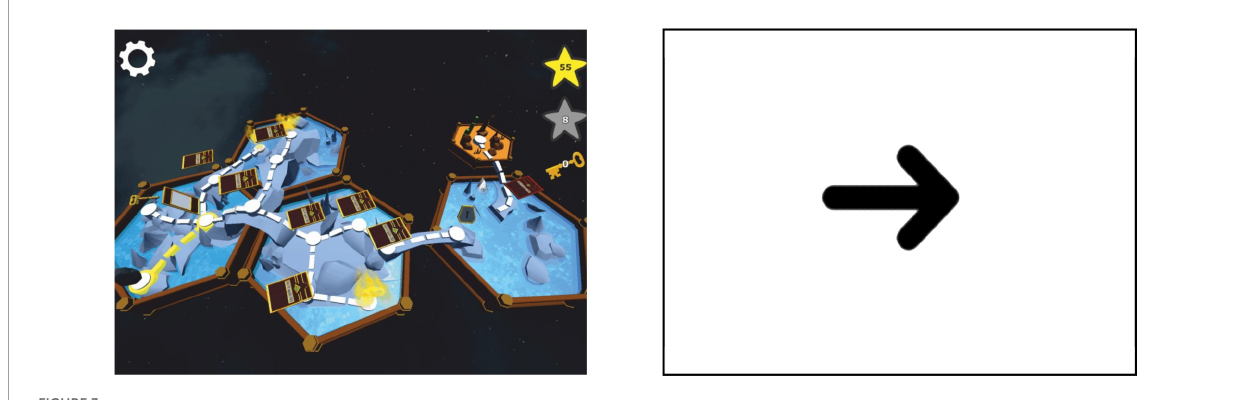
FIGURE3 An example of a game level (left) and a non-game level (right) .